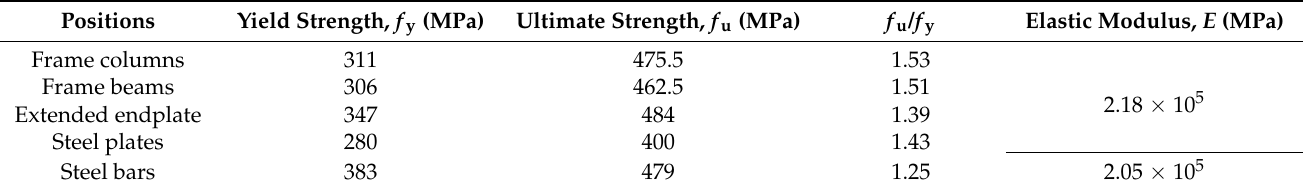
Table 2. Properties of steel and steel